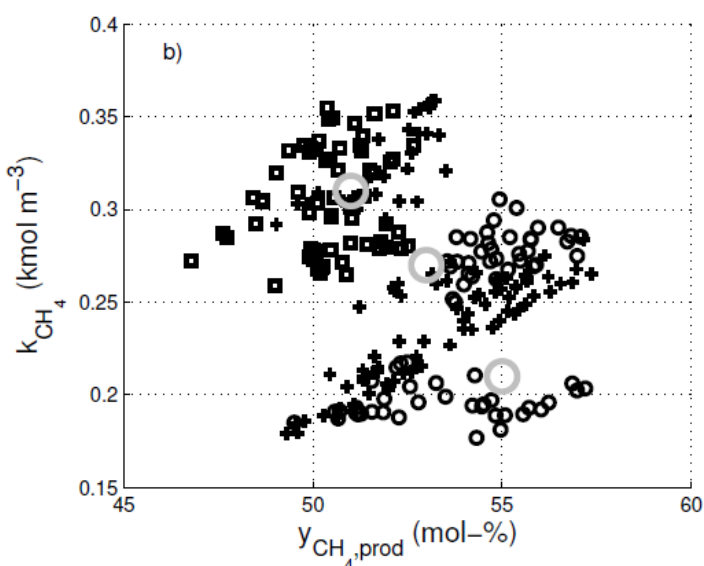
Figure 3. Gas production characteristics with different circulation flows (0 L·day − 1 , 20 L·day − 1 and 40 L·day − 1 ). The calculation scenarios are indicated as grey circles. The